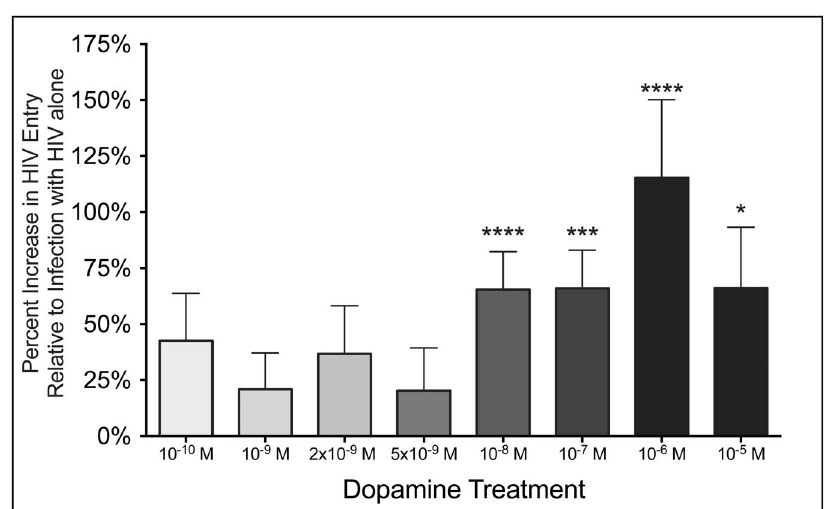
Figure 2. I ncrease in HIV entry requires a minimum threshold of dopamine. MOI 0.01 b -lac HIV was added to macrophages in the presence of 10 10 , 10 9 , 2 6 10 9 , 5 6 10 9 , 10 8 , 10 7 , 10 6 M and 10 5 M dopamine and control cells were infected with HIV alone. Relative to control infections, viral entry was significantly increased when MDM were infected with HIV in the presence of 10 8 , 10 7 , 10 6 M and 10 5 M dopamine (n=1032, ** p , 0.01, *** p , 0.001 vs. HIV only) but not in the presence of 10 10 , 10 9 , 2 6 10 9 , or 5 6 10 9 M dopamine. There was no significant difference in the magnitude of the increase in entry among cultures infected the presence of 10 8 , 10 7 , 10 6 M and 10 5 M dopamine.